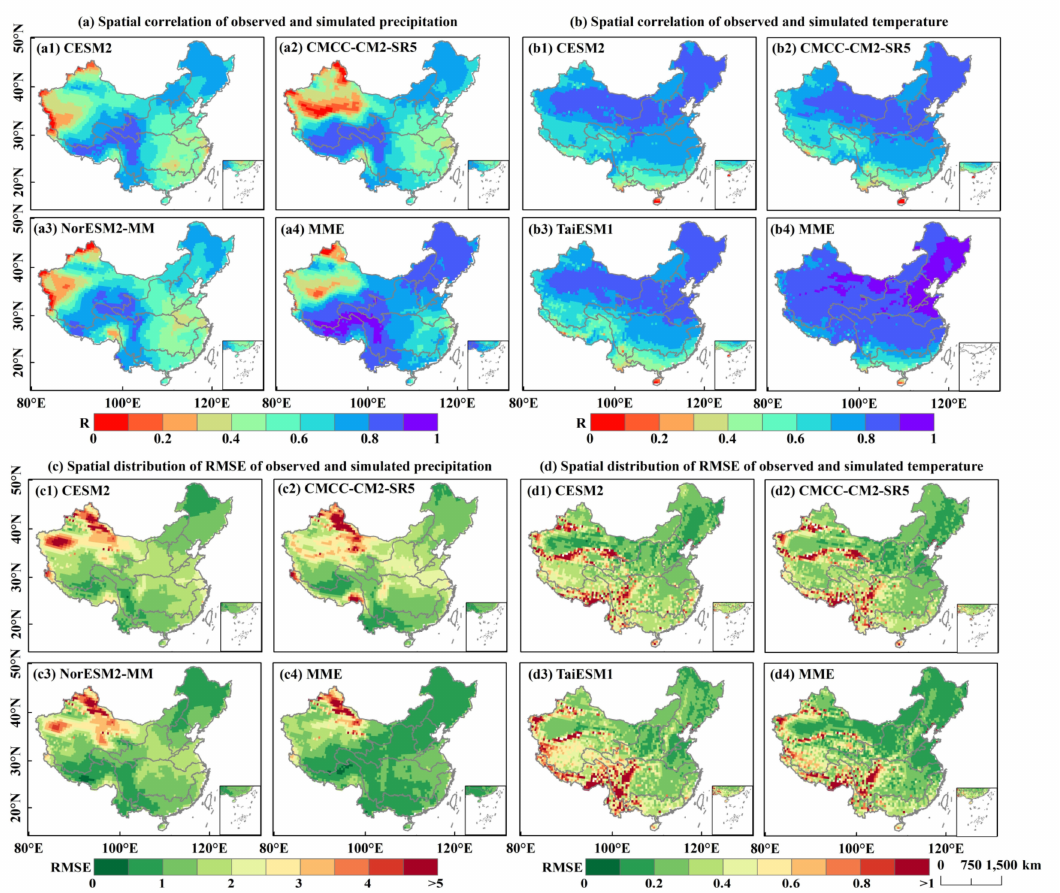
Figure 4. Correlation coefficients between the observed and simulated ( a ) precipitation and ( b ) temperature, and ( c , d ) root mean square error between the simulations and observations in 1961–2014. The correlation coefficients (R) between monthly simulations and observations across China were calculated using Equation (1). The root mean square error (RMSE) between monthly simulations and observations across China were calculated using Equation